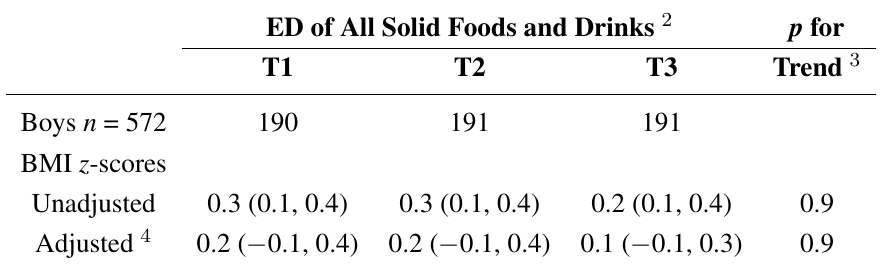
Table 3. Association of ED of all solid foods and drinks with BMI z -scores, %BF, FMI, FFMI and WHR among children aged 8–14 years 1